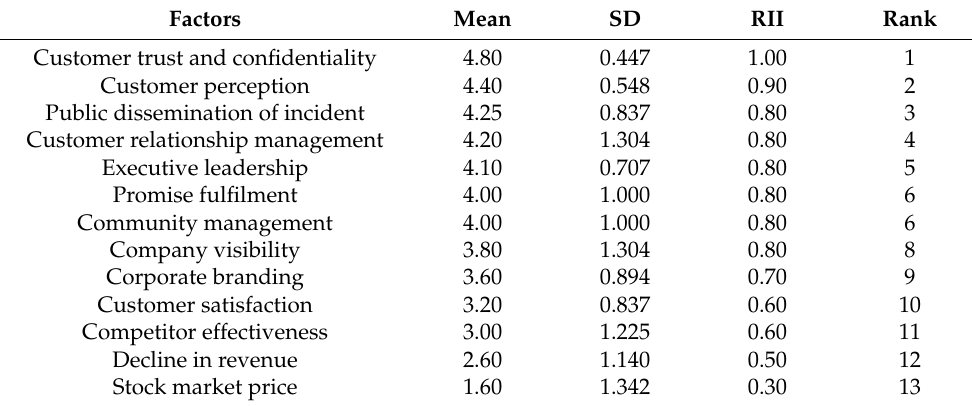
Table 4. Classification under strategy.